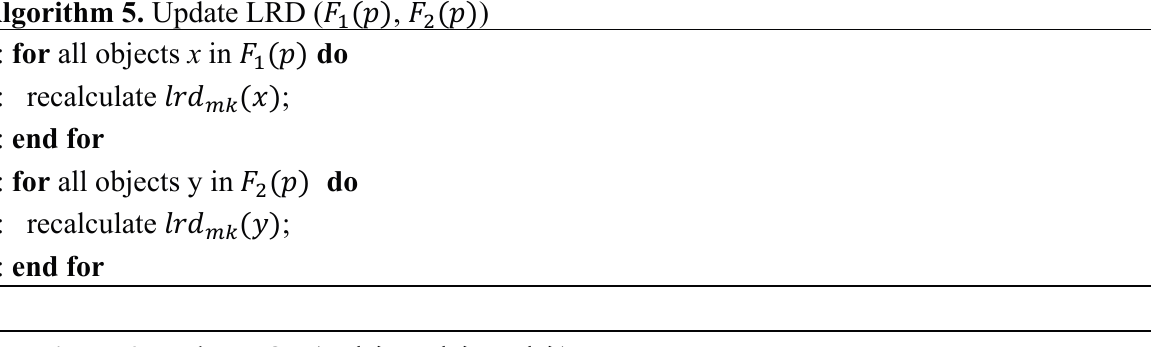
((cid:1868)) , (cid:1832) ((cid:1868)) (cid:2869) (cid:2870)